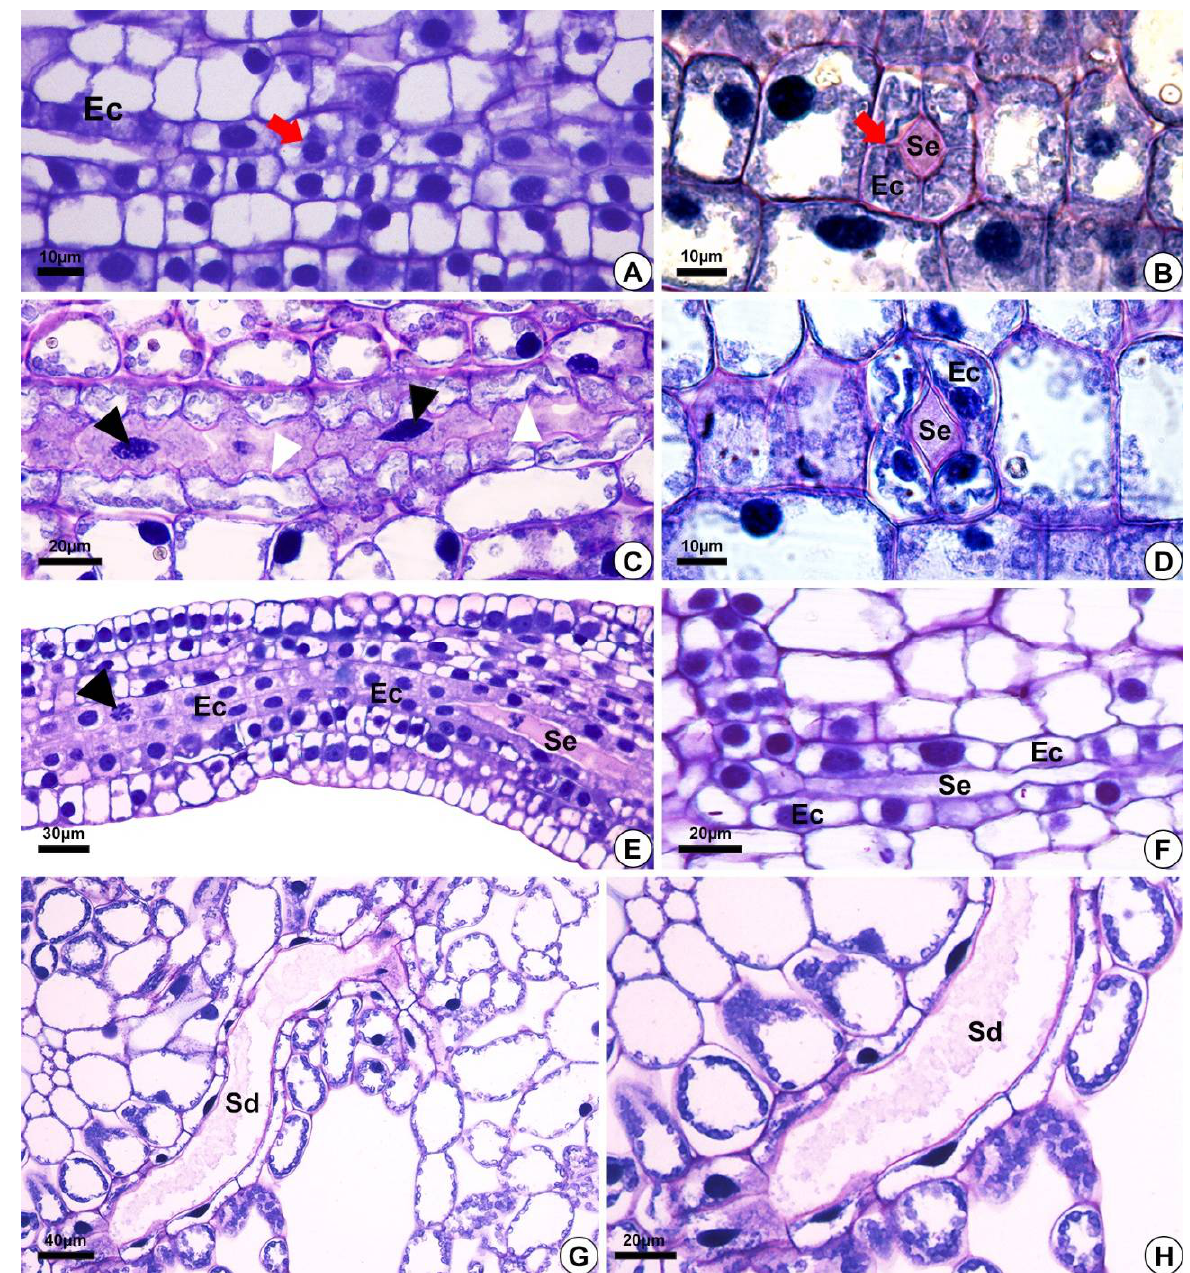
Figure 2. Light micrographs after staining with toluidine blue, depicting the development of secretory ducts in Helanthium tenellum , Hydrocleys nymphoides, Limnocharis flava and Sagittaria rhombifolia . ( A , F ) Hydrocleys nymphoides . ( B – D ) Limnocharis flava . ( E ) Helanthium tenellum . ( G , H ) Sagittaria rhombifolia . Longitudinal ( A , C , E , F ) and cross-section ( B , D ) of the floral meristem. ( A , B ) Secretory ducts originated from the ground meristem by asymmetrical mitotic divisions (red arrow) (A). The initial epithelial cells start to pull away (schizogeny) and give rise to the lumen (B). ( C ) Secretory duct development. Note epithelial cells with fusiform nuclei (black arrowheads), and an undulating cell wall (white arrowheads). ( D – F ) Epithelial cells with large nuclei and dense cytoplasm. ( E ) Epithelial cells in division (arrowhead), with an increase in the number of secretory cells around the lumen. ( G , H ) Mature secretory ducts. ( G ) Branching of secretory ducts by anastomosis. ( H ) Note the presence of secretion. Sd = secretory ducts. Ec = epithelial cells. Se = secretion.